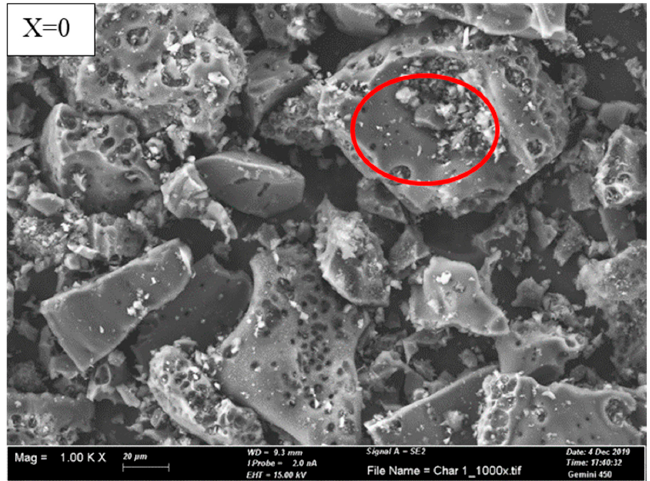
Figure 7. SEM images (1000× magnification) of the original char. Energies 2020 , 13 , x FOR PEER REVIEW